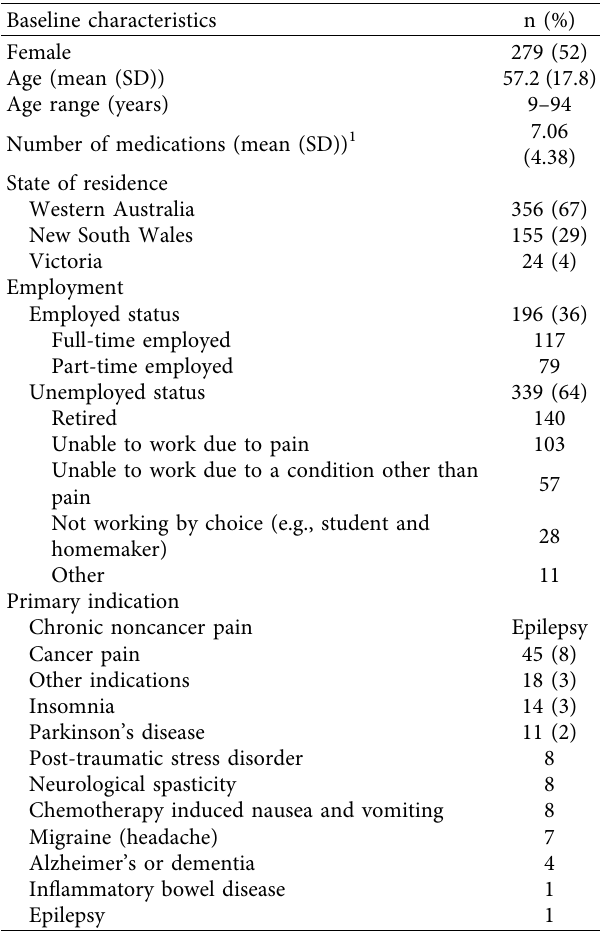
Table 3: Baseline characteristics ( n �